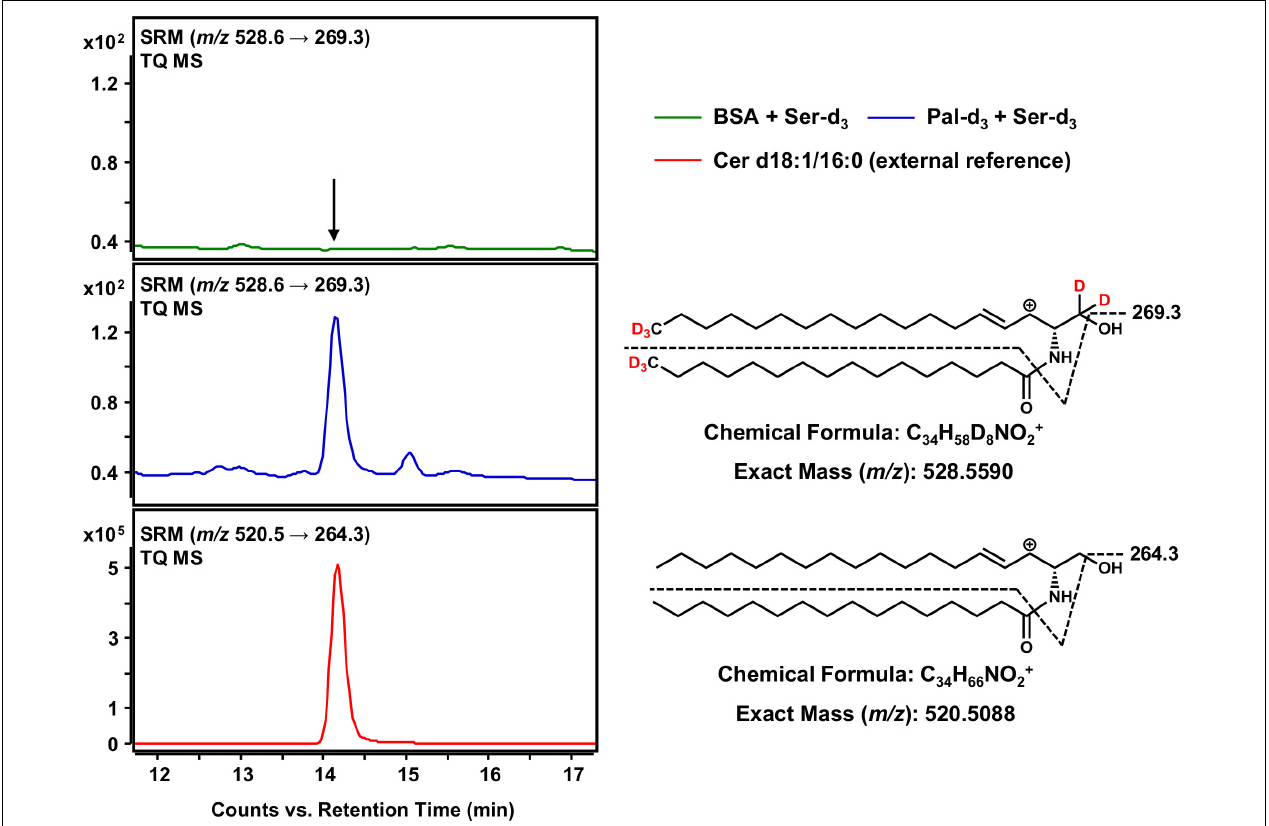
FIGURE 6 | Detection of Cer d18:1-d 5 /16:0-d 3 as the terminal product of the sphingolipid de novo synthesis assay. (Right) Chemical structures, formulas and exact masses of the dehydrated, protonated molecular ions [M-H 2 O+H] + of Cer d18:1-d 5 /16:0-d 3 and the unlabeled analog Cer d18:1/16:0, generated during electrospray ionization. Dashed black lines represent the mass transitions used for selected reaction monitoring (SRM). (Left) SRM analyses of assay sample (addition of palmitate-d 3 and serine-d 3 , blue), negative control sample (omission of palmitate-d 3 , green) and external Cer d18:1/16:0 standard (red) were performed with a triple quadrupole mass spectrometer (TQ MS). The arrow indicates the retention time of Cer d18:1/16:0 (labeled and unlabeled).